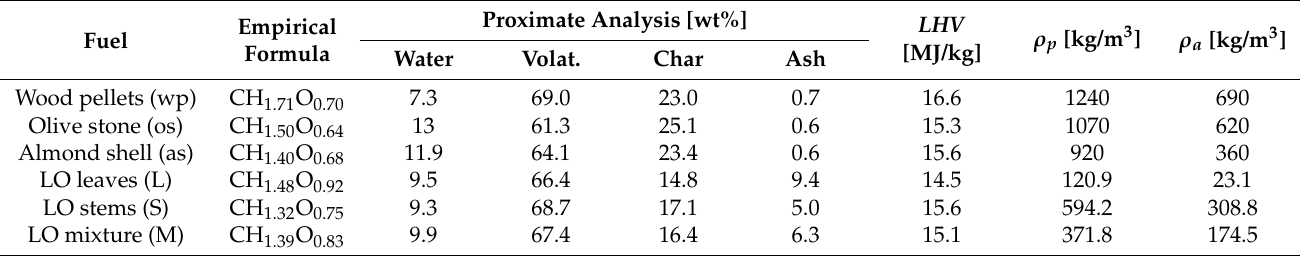
Table 1. Fuel composition and